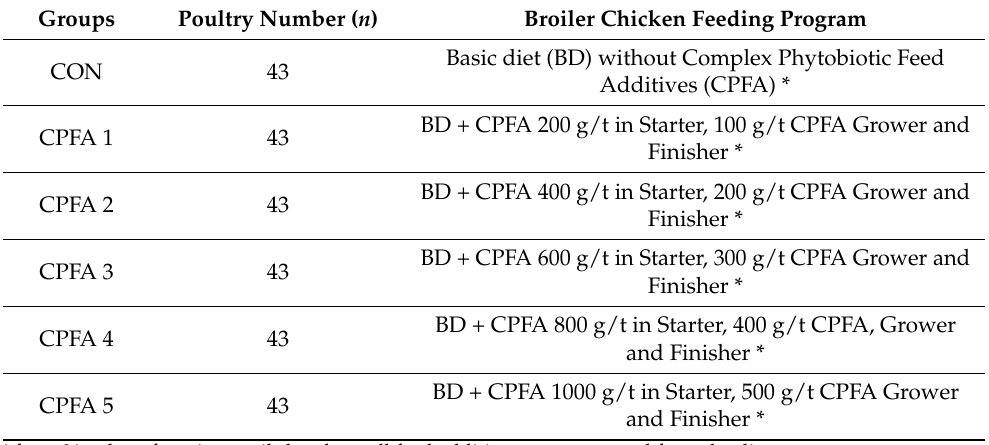
Table 1. Feeding scheme and research